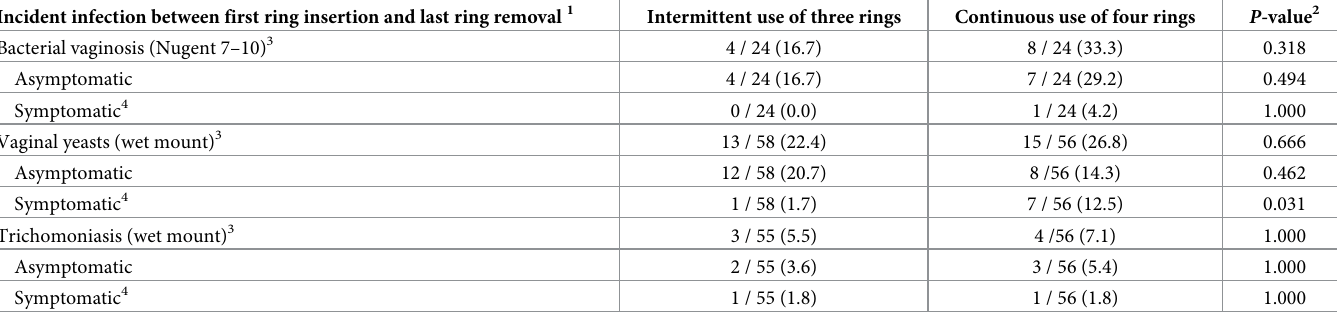
Table 3. Laboratory-confirmed bacterial vaginosis, vaginal yeasts and trichomoniasis by randomisation group. Incident infection between first ring insertion and last ring removal 1